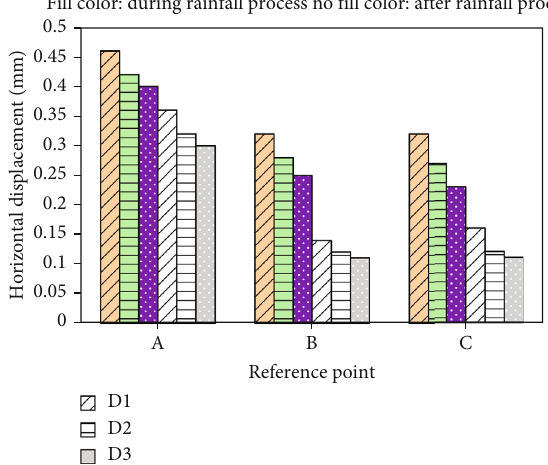
Figure 19: Di ff erent values of horizontal displacement at the reference points for di ff erent vegetation types.